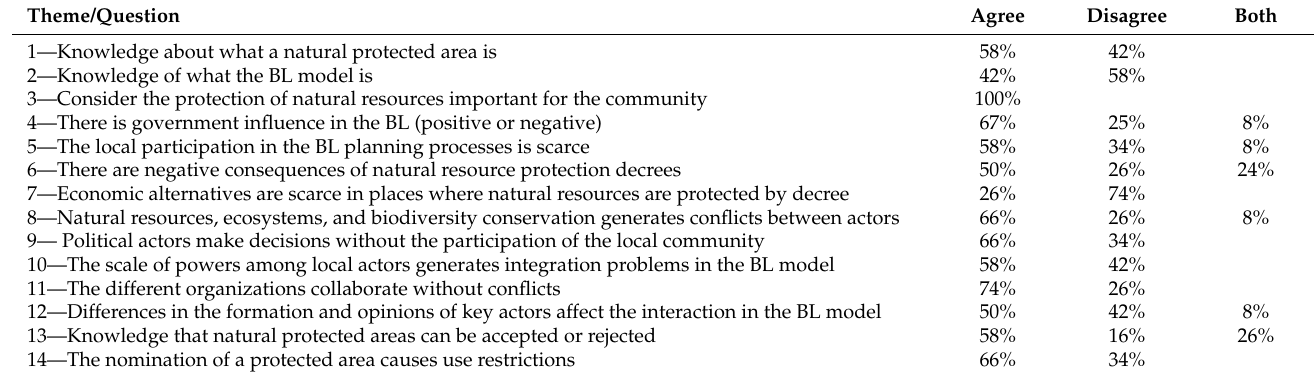
Table 4. Type of response by theme related to